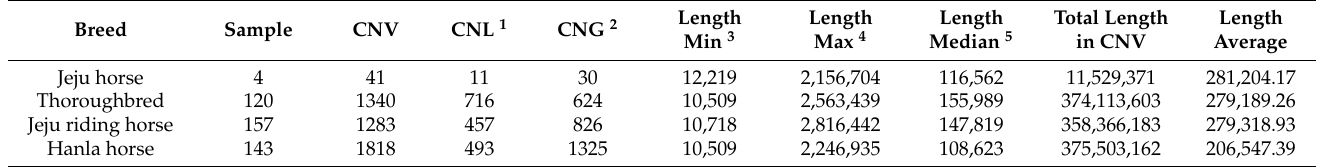
Table 1. Copy number variation (CNV) analysis of four horse breeds in South Korea.